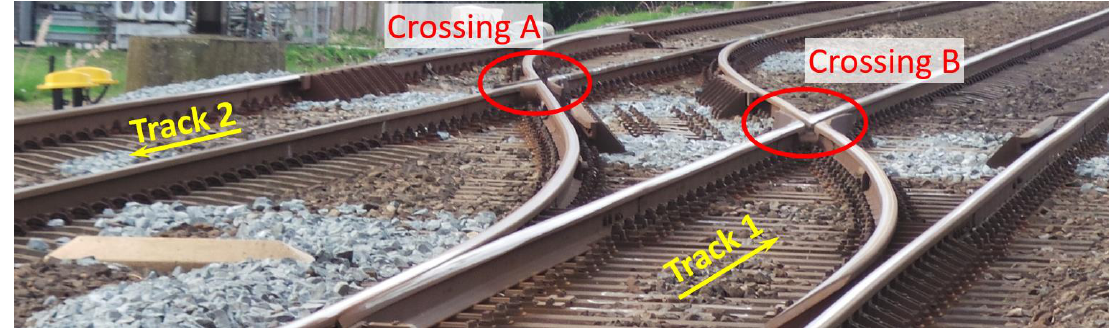
Figure 3. Typical crossover in the Dutch railway network.